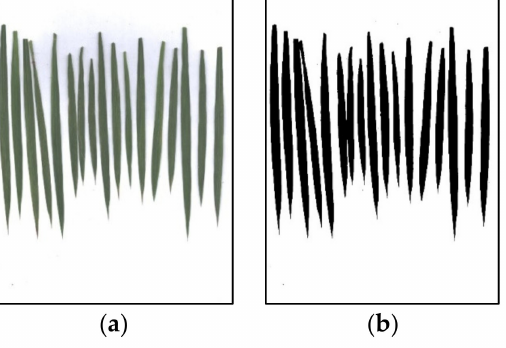
Figure 2. ( a ) Scanned image of the leaves; and ( b ) the binarized image results of the scanned